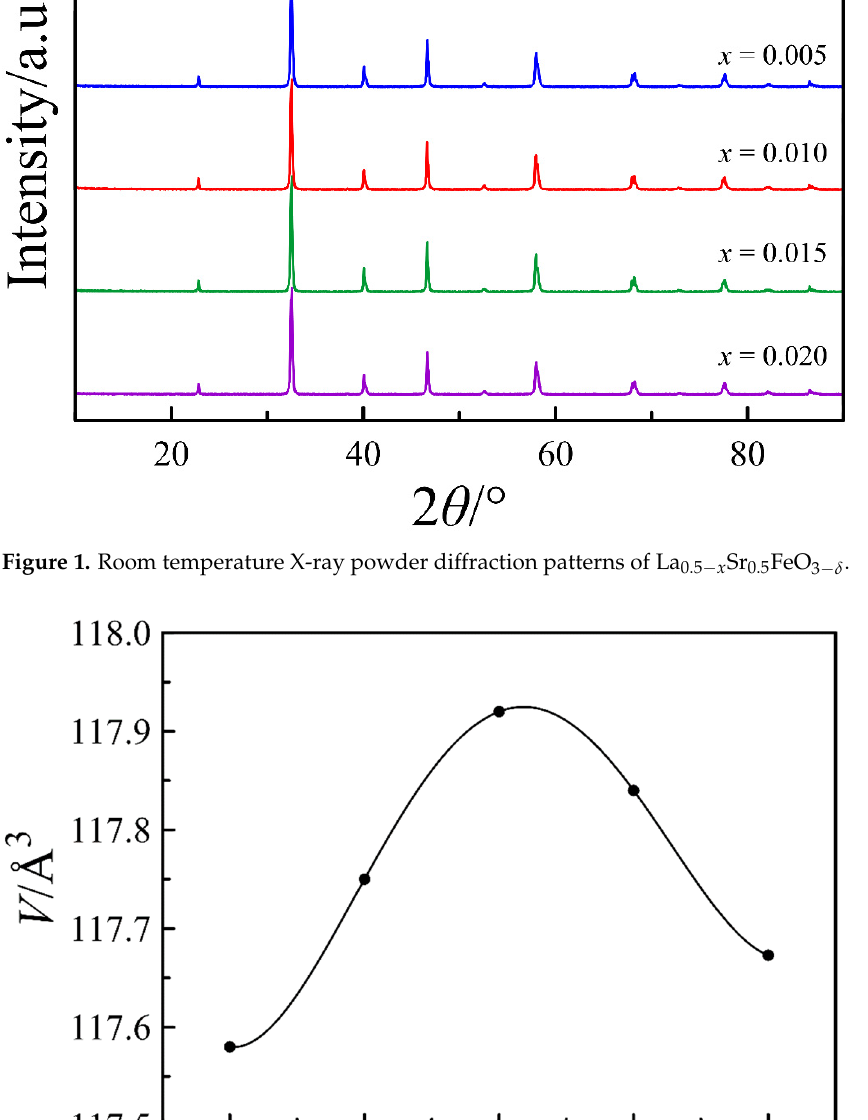
Figure 2. Unit cell volume of La 0.5 − x Sr 0.5 FeO 3 − δ as a function of A-site deficiency.